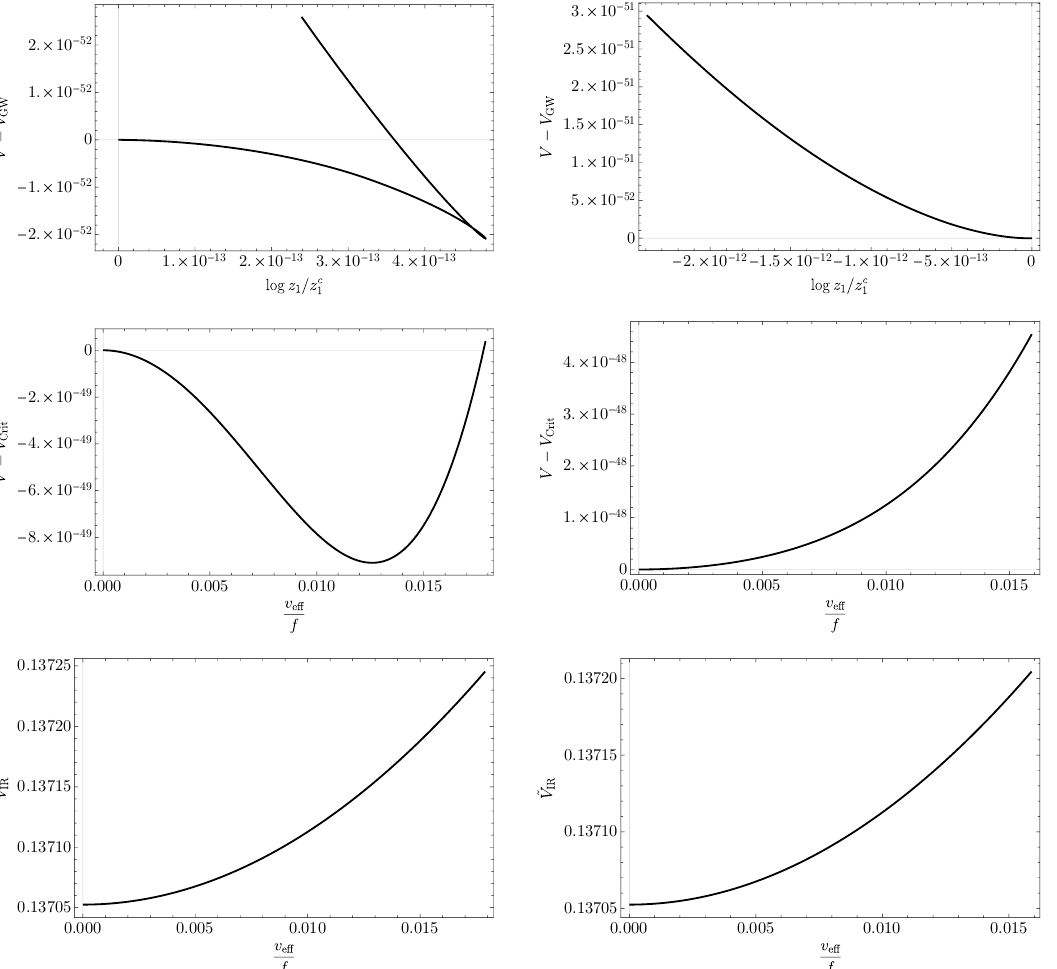
Figure 6. In this plot, we show the radion potential for two di(cid:11)erent values of v 2 In the column on the left, v 2 > v 2 (crit). We have taken (cid:15) = v 0 = 1 = 10, m 2 H H (cid:14)T 1 = (cid:0) 1 = 10, (cid:21) = 1 = 3, m 2 = 4 : 1, and (cid:21) H = 1 = 8. The critical point is between v 2 0 v 2 = (cid:0) 16 : 5831, and the two columns correspond respectively to these two values of v 2 H v 2 (crit). In descending order, the plots display: the di(cid:11)erence between the radion potentials with H and without a Higgs VEV as a function of log z 1 =z 1 (crit), the same potential with V crit being its value at the critical z 1 , but instead as a function of v e(cid:11) =f , and (cid:12)nally the value of e V IR , de(cid:12)ned in eq. (3.21), indicating the degree of mismatch of the metric junction condition on the IR brane. There is no discernible di(cid:11)erence in these two plots on either side of the critical value of v 2 there is certainly no zero.